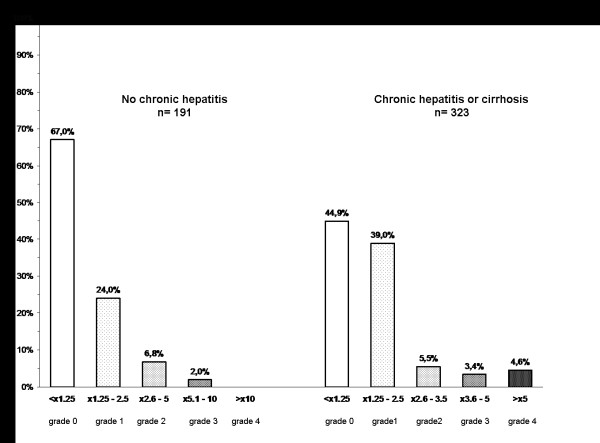
Proportion of patients (n) who developed aminotransferase elevations in any determination throughout the follow-up.